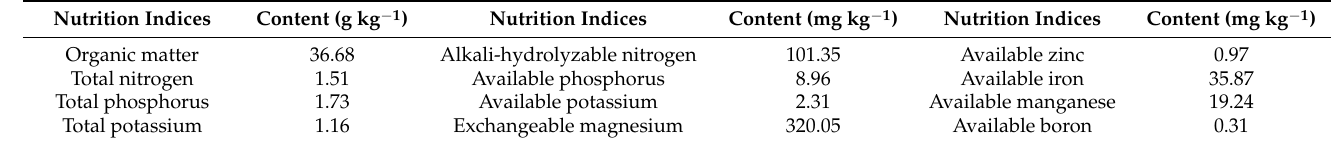
Table 2. The nutritional information of kiwifruit’s planting